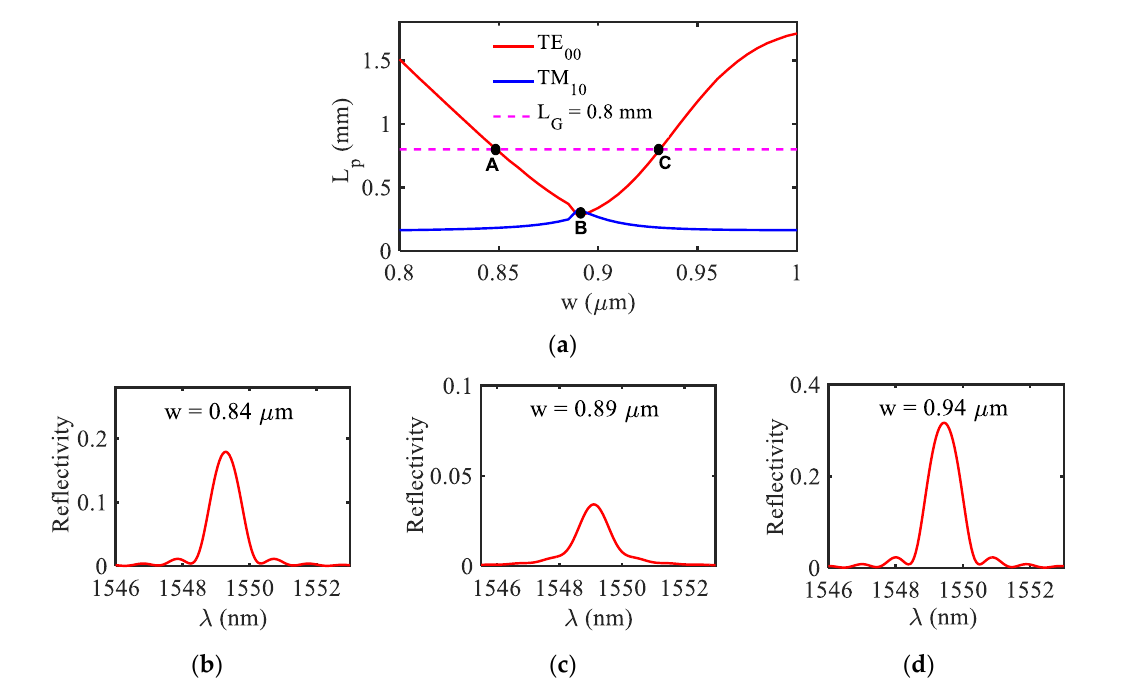
Figure 5. ( a ) Propagation length of TE 00 and TM 10 mode as a function of width of HI-MCRW. Re- flected spectrum of HI-MCRW corresponding to TE 00 mode for three different widths ( b ) w = 0.84 µm, ( c ) w = 0.89 µm, ( d ) w = 0.94 µm as represented by three different points A, B, and C in ( a ).